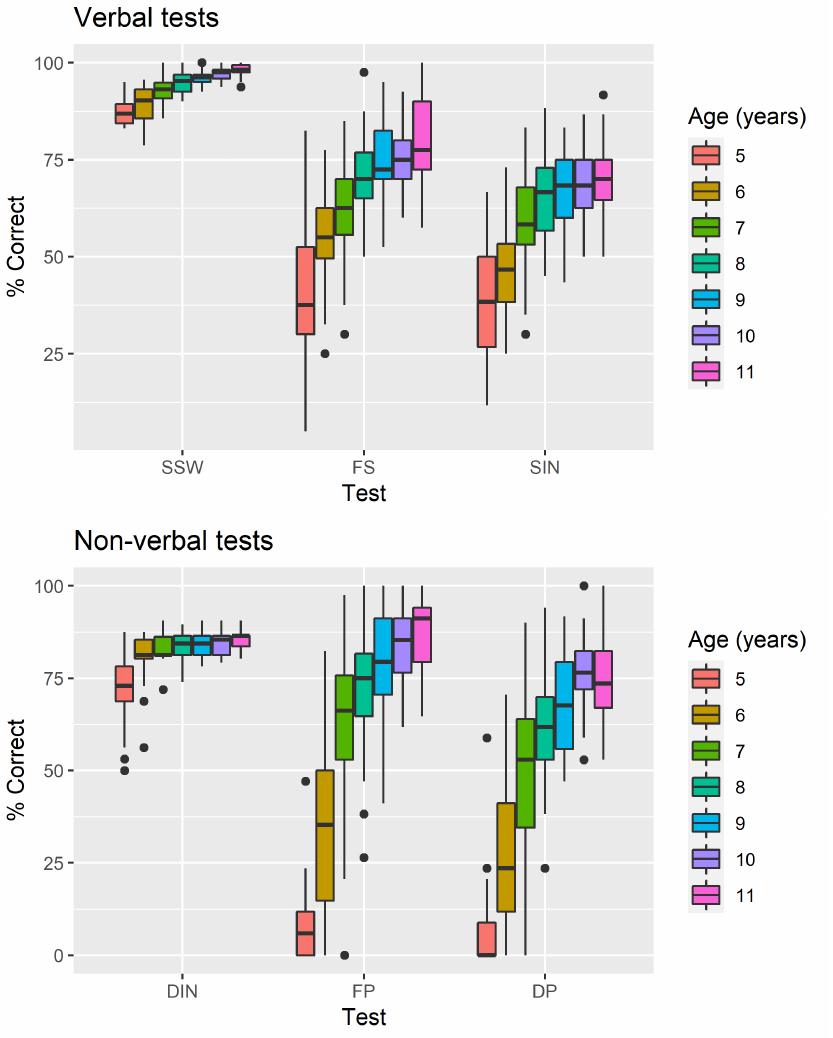
Figure 2. Boxplots for the percentage of correct answers for the 6 tests of the battery by age group. For monaural tests, only results for right ear are